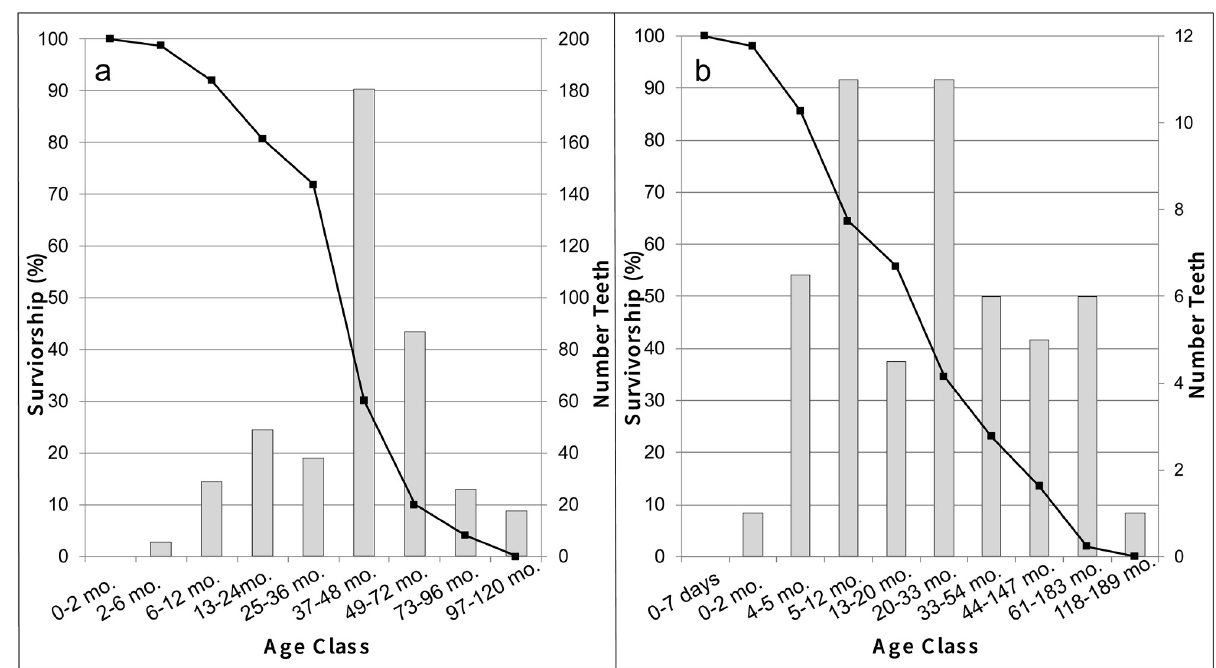
Fig 5. Survivorship curves (black lines) and tooth frequencies (gray bars) according to age classes for (a) sheep/goat and (b) fallow deer based on analysis of eruption and wear of teeth from Politiko- Troullia .